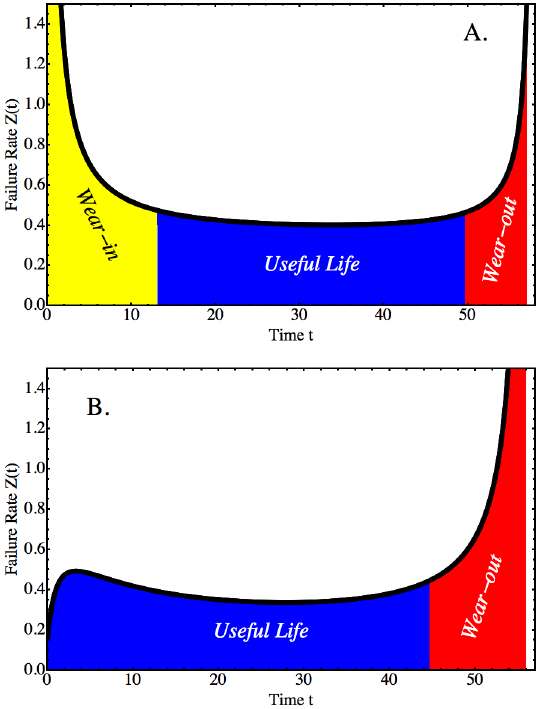
Figure 1. Failure Rate Kinetics of Machine and Clonal Blood Cell Populations. Schematic representations of the failure rate kinetics (vertical axis) of two systems over time (horizontal axis): A. Population of machines; B. Population of cells derived from a single long-term repopulating hematopoietic stem cell (HSC). In reliability theory, it is thought that three major phases describe the shape of the failure rate function (the black curve in Parts A and B was generated for demonstration purposes using appropriate mathematical functions). A: For populations of machines, the ‘‘bathtub’’ shape is thought to begin with a ‘‘wear-in’’ phase (yellow). During ‘‘wear-in’’, factory